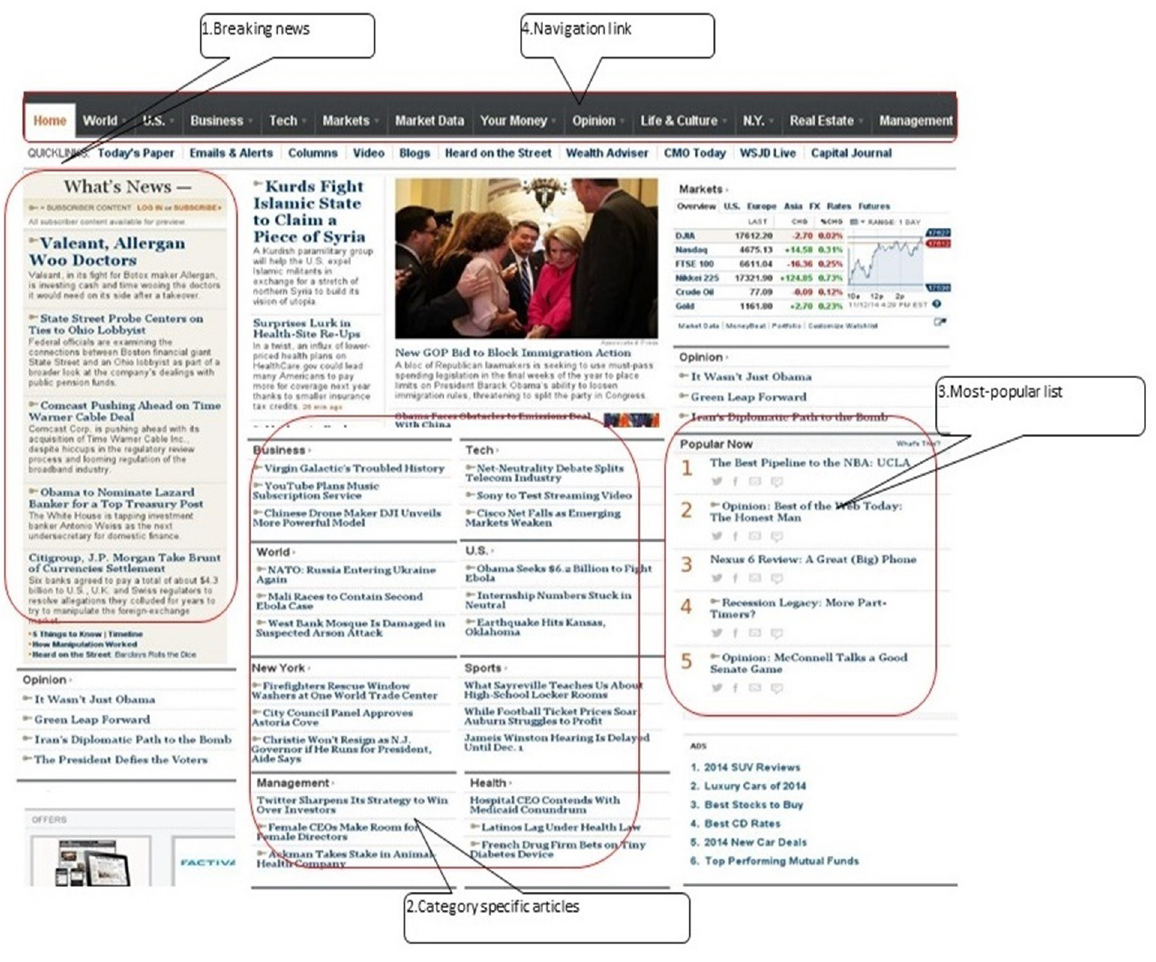
Fig 1. Common features available on the front page of a news